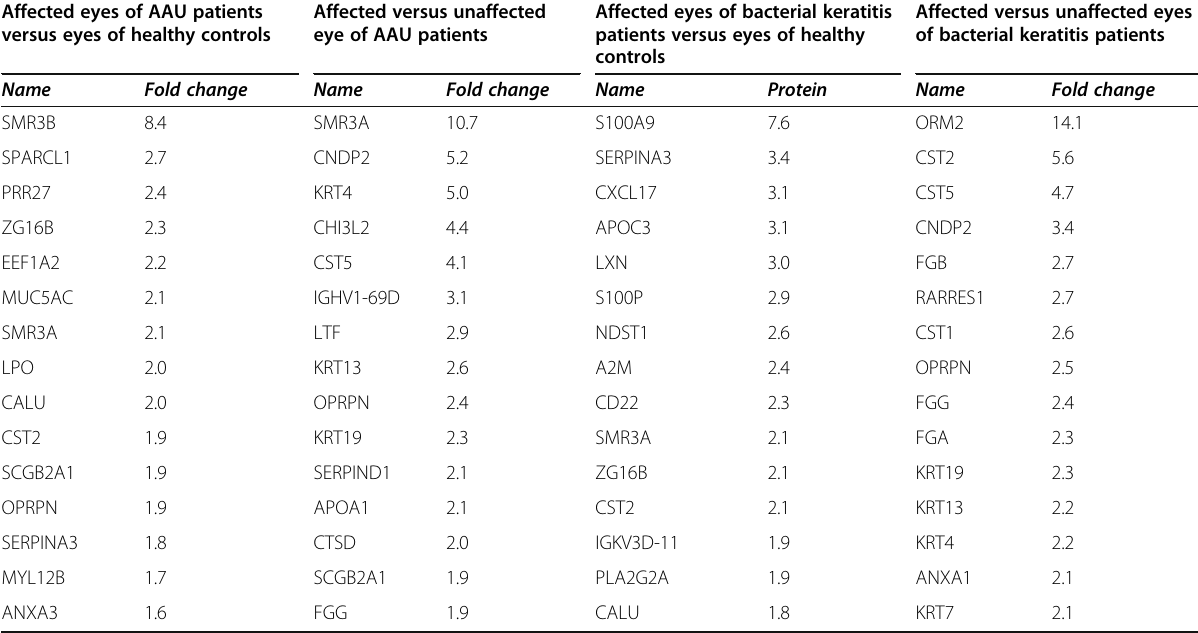
Table 2 Top 15 upregulated tear fluid protein level ratios Affected eyes of AAU patients versus eyes of healthy controls